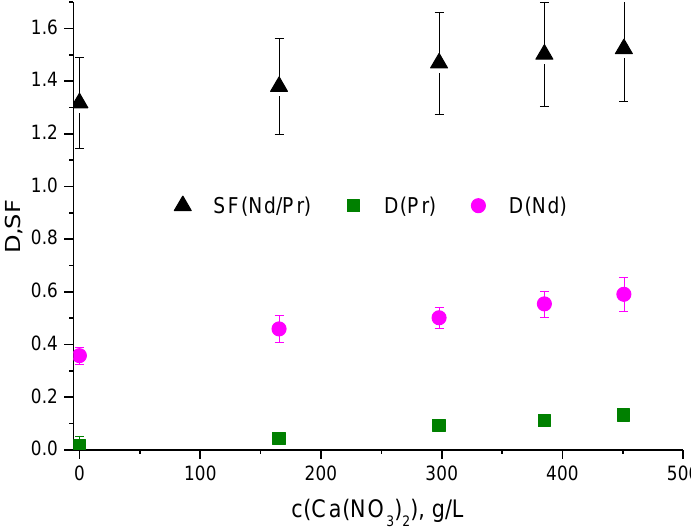
Figure 4. Dependence of distributions ratios and separation factors for Nd and Pr in the system: “Pure TBP—neodymium + praseodymium + calcium nitrate + 0.3 mol · L − 1 HNO 3 ” .